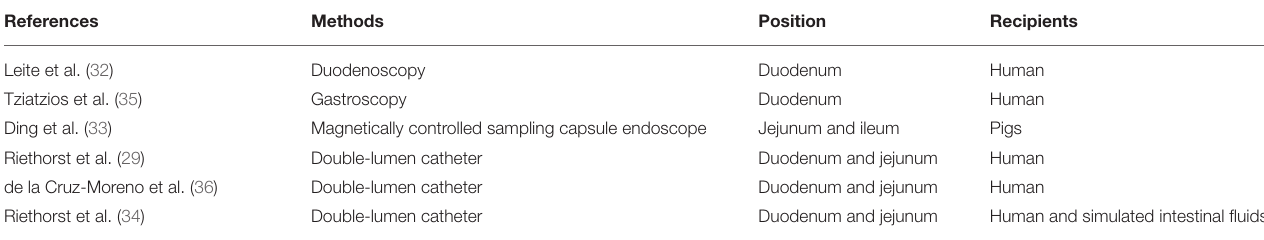
TABLE 1 | Different methods in achieving HIF biopsy in recent 5